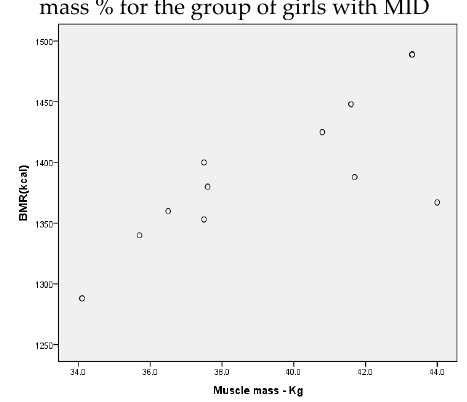
Graph 5. Correlation between BMR and muscle mass (kg) for the group of girls without ID